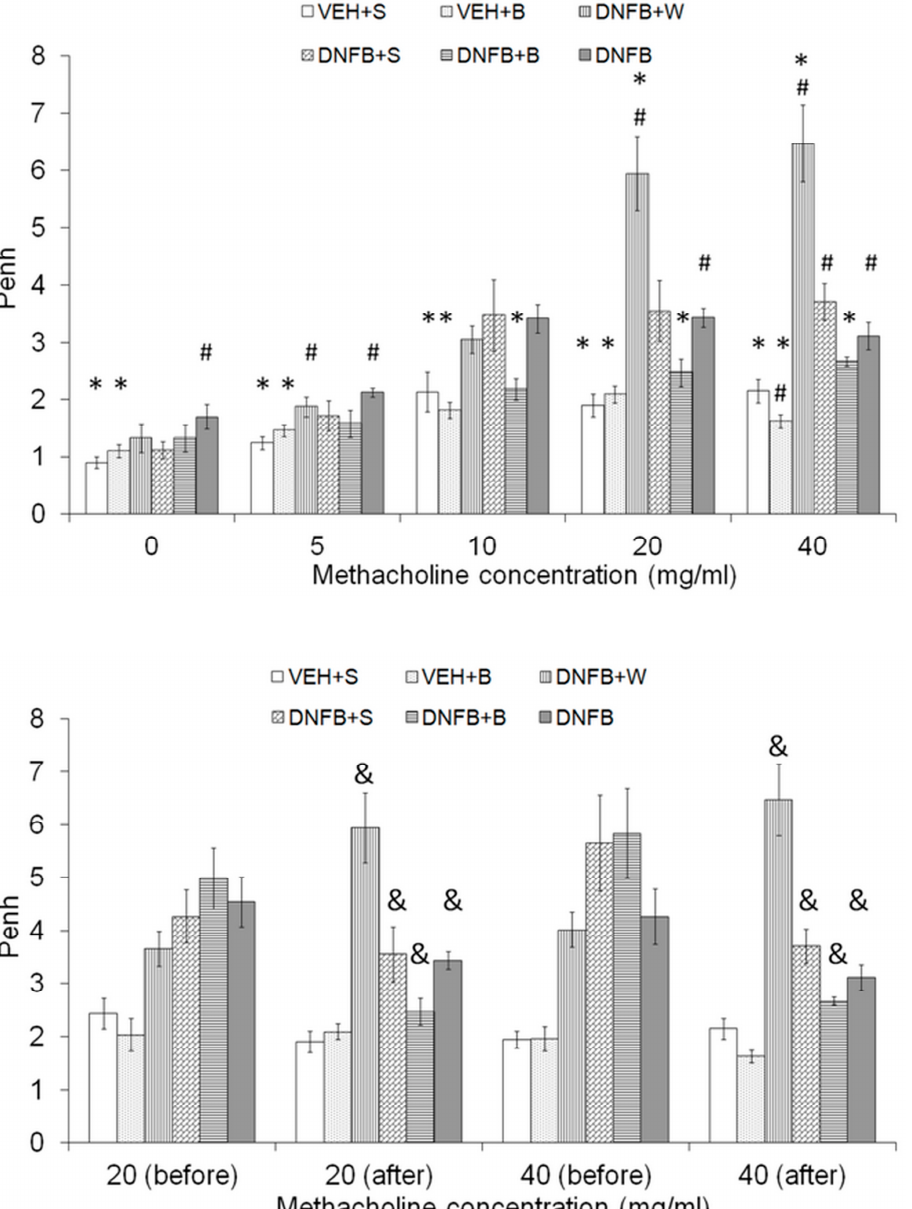
Figure 1. Upper panel: Airway hyperreactivity to methacholine. # p < 0.05 vs. VEH + S (Mann–Whitney U test); * p < 0.05 vs. DNFB (Mann–Whitney U test); means ± SE, n = 5–10. Lower panel: